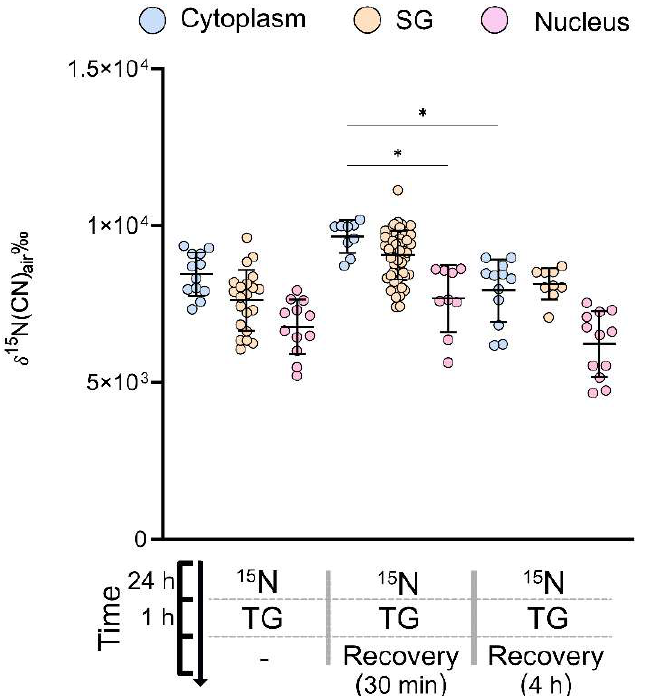
Figure 4. Protein turnover (expressed as 15 N enrichment) of SGs and the cytoplasm during the stress recovery. The timeline (bottom) shows the treatment procedures for three cell groups: no recovery (n = 12), 30 min recovery (n = 9), and 4 h recovery (n = 12). A one-way non-parametric ANOVA finds statistical differences between the means of at least two groups (Dunn’s, * p < 0.05). Only statistical differences between the same organelles at different time-points, or different organelles at the same time-point, are shown. The mean δ 15 N for all time-points is 8589 ± 1031‰ in the cytoplasm and 8628 ± 1016‰ in the SGs; n is the number of cells.